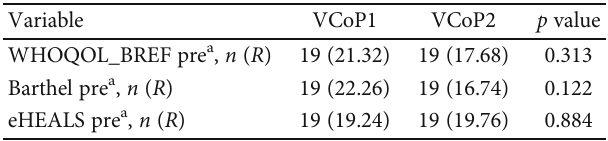
Table 2: Statistical di ff erences between caregivers ’ WHOQOL- BREF, Barthel, and eHEALS preintervention of the two groups. Variable VCoP1 VCoP2 p value WHOQOL_BREF pre a , n ( R )